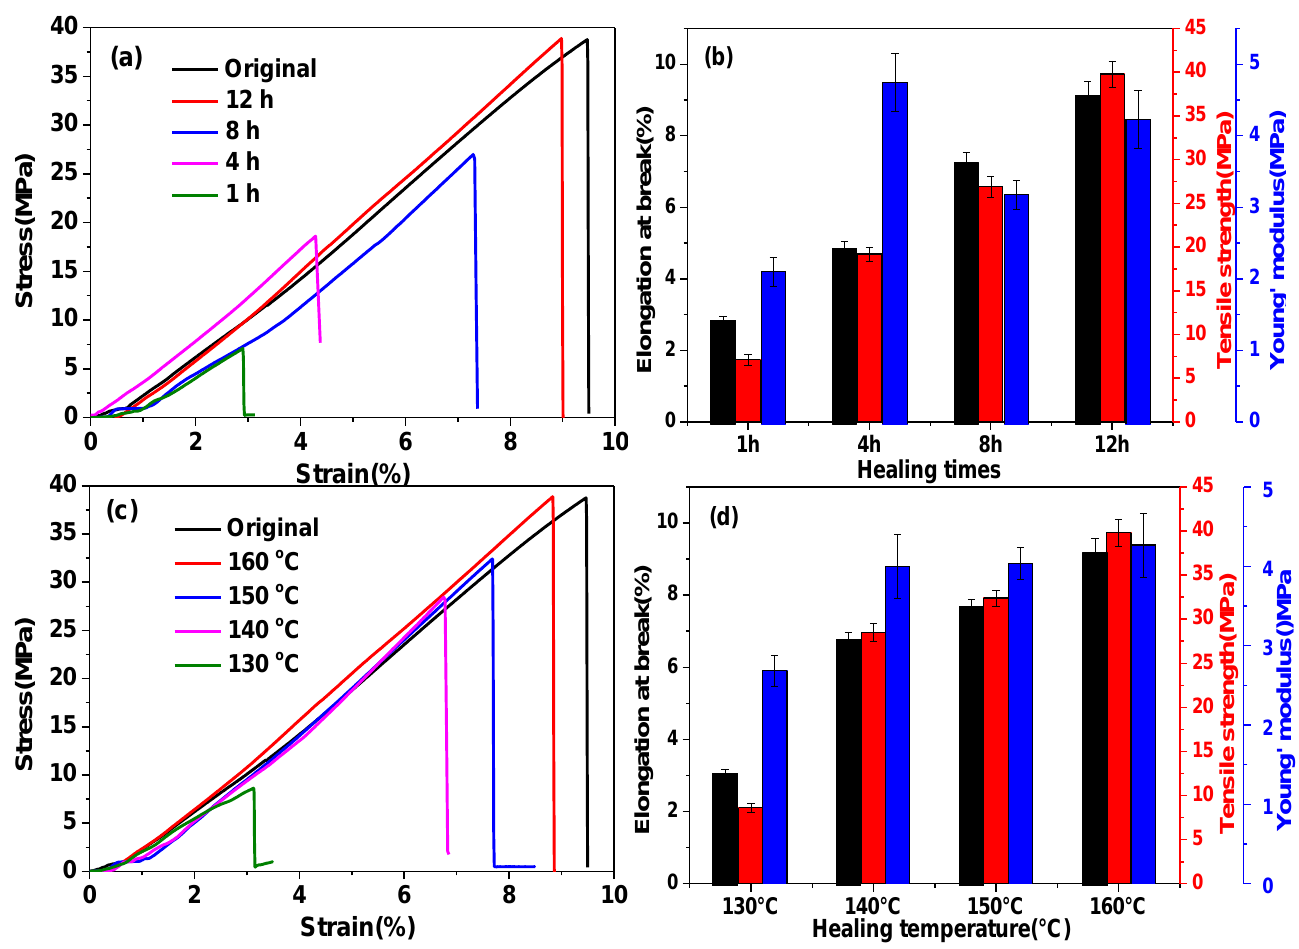
Figure 9. ( a ) Tensile curves of 20% C-FPEA welding at 160 ◦ C for various times. ( b ) Mechanical properties of 20% C-FPEA welded at 160 ◦ C for various times. ( c ) Tensile curves of 20% C-FPEA welding at 12 h for various temperatures. ( d ) Mechanical properties of 20% C-FPEA welded at 12 h for various temperatures.